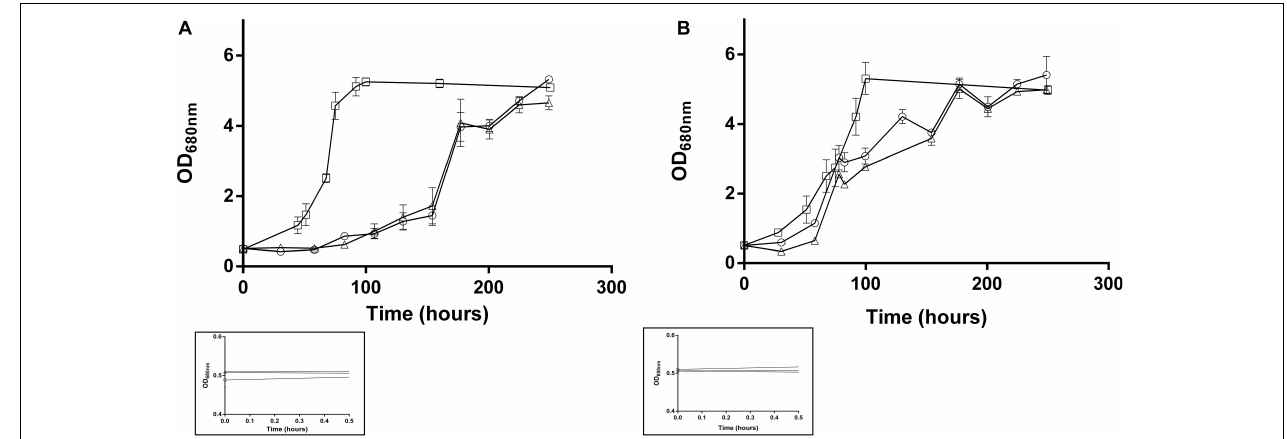
FIGURE 1 | Growth of the Rs. rubrum WT (A) or acetate-competent (B) strains in medium containing different concentration of added bicarbonate ions (0 mM: triangle; 3 mM: circle and 50 mM: square). Framed growth curves represent the early growth phase and the starting inoculum, n = 5.